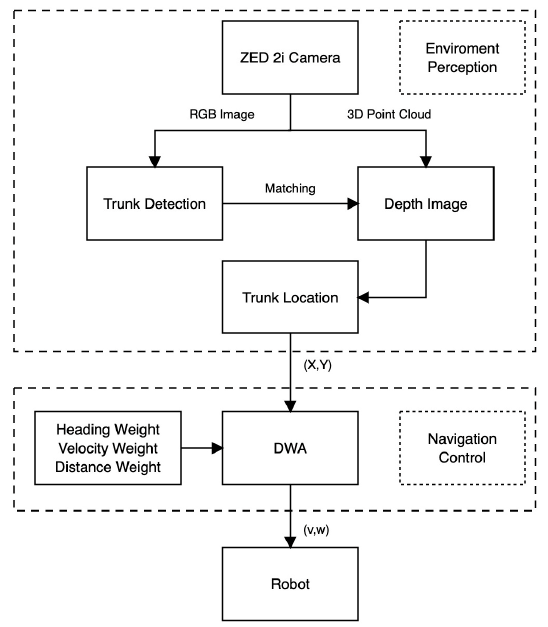
Figure 1. Methodology block diagram.